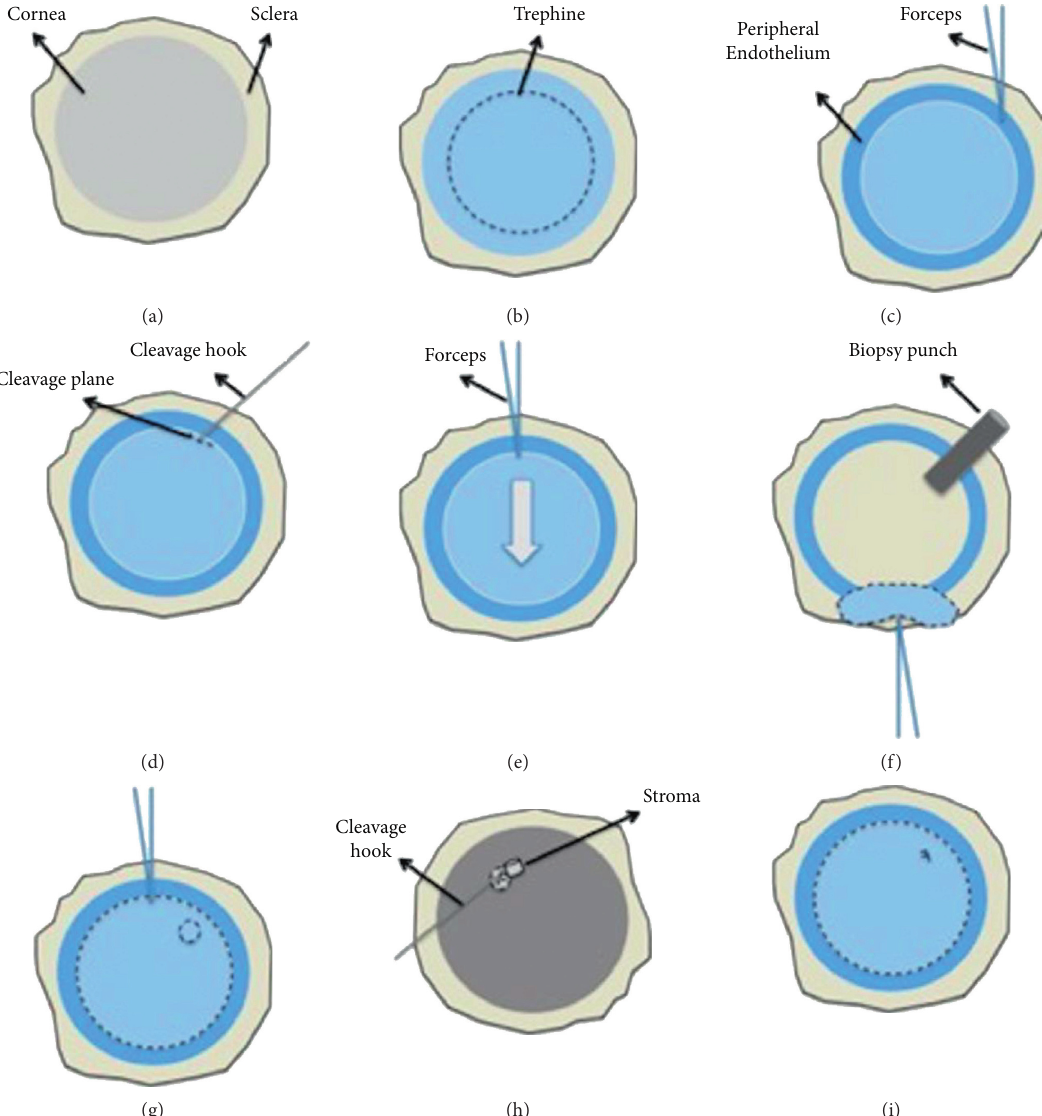
Figure 1: The double trephine technique: (a) healthy corneal tissue; (b) cut margins; (c) peripheral endothelium is removed; (d) separate the periphery of the central endothelium from the stroma; (e) the separated periphery is then grasped using the sharp acute forceps at the superior end and is peeled towards the inferior end; (f) a biopsy punch is used to create a small stromal punch; (g) the peeled DMEK tissue is replaced back on the stroma; (h) the tissue is marked; (i) endothelium is restained using trypan blue.